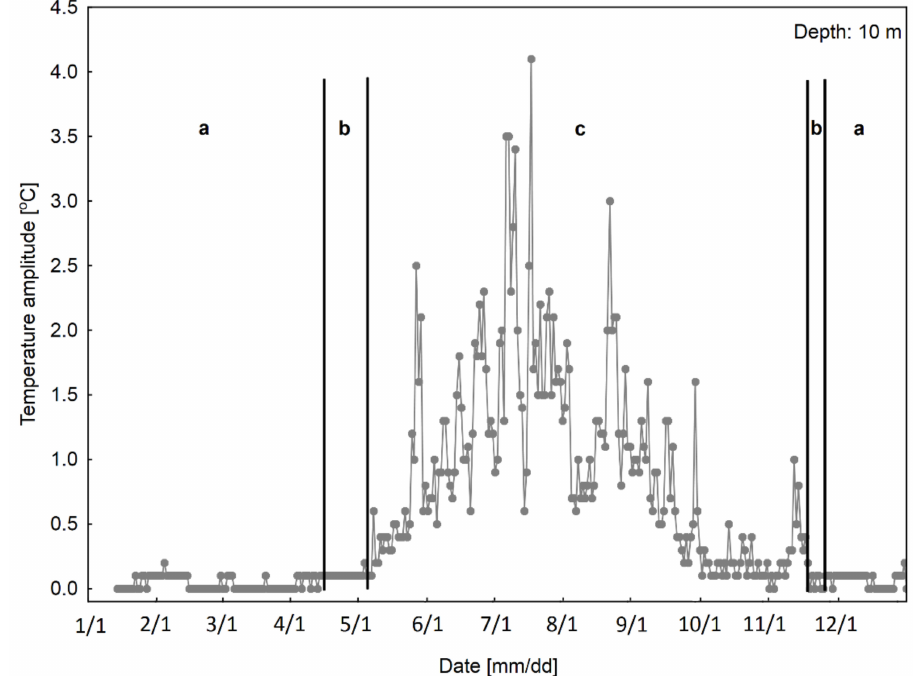
Figure 3. Changes in water temperature amplitudes in time at a depth of 10 m. a—presence of ice cover; b—occurrence of ice phenomena; c—lack of ice cover/ice phenomena.